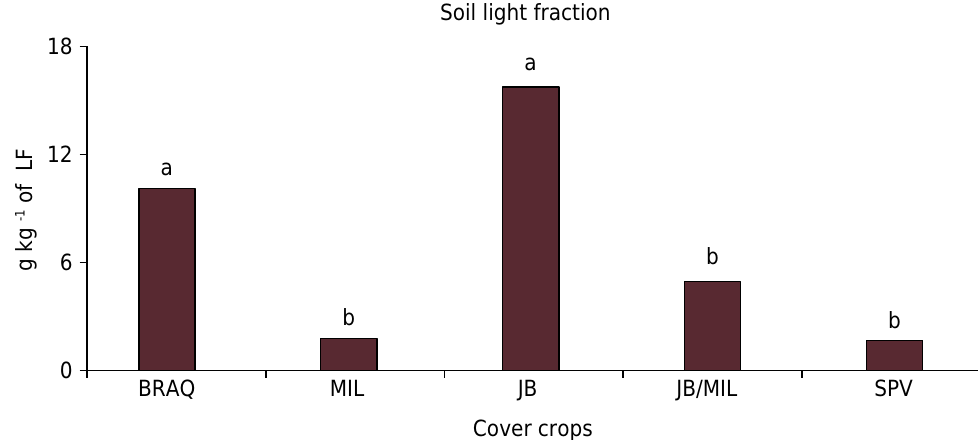
Figure 1. Soil light fraction (LF) contents extracted from the 0.00-0.10 m layer in an orange orchard with different cover crops. Means followed by the same lower-case letters do not differ significantly by the Scott-Knott test